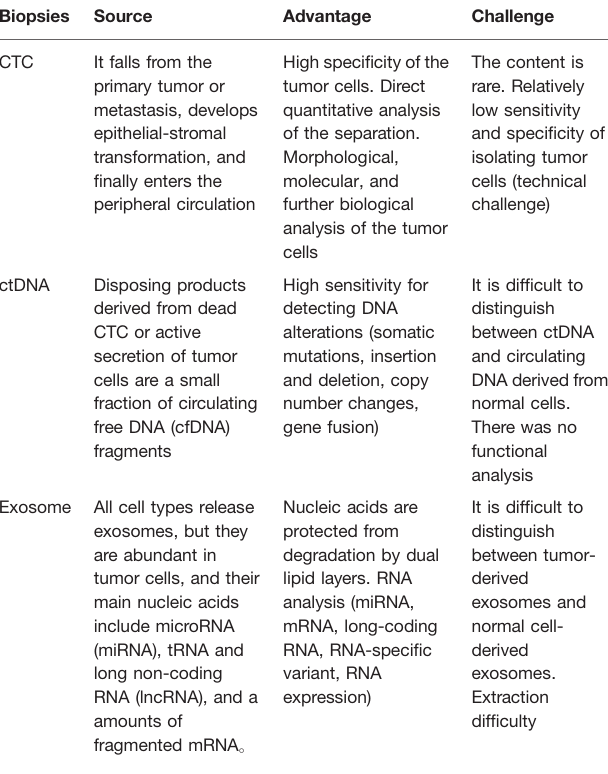
TABLE 1 | Comparison of the three common biopsy subjects in body fl